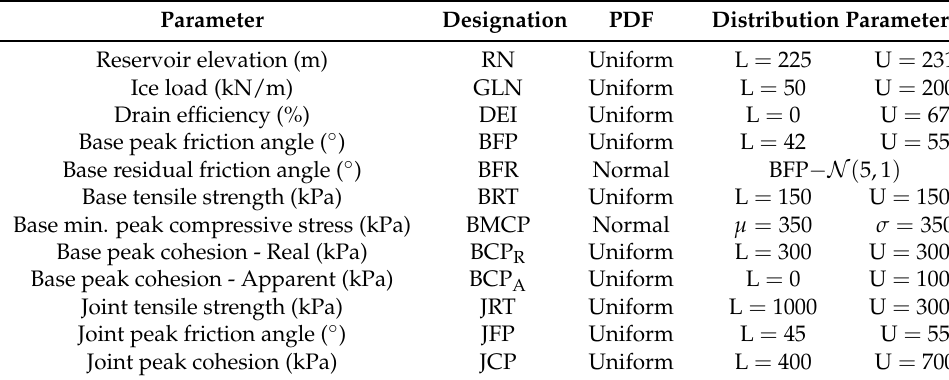
Table 2. Uncertain parameters.